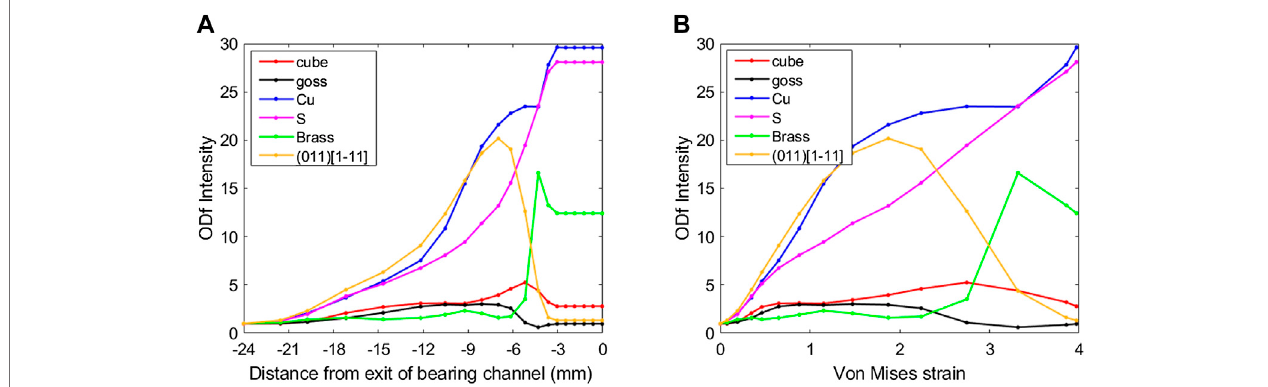
FIGURE 8 | Through-extrusion texture components development prediction by the Alamel model with parameters giving the best fi t to the measured texture at 350 ° C, plotted as a function of (A) the Von Mises strain, (B) distance from exit of bearing channel along the extrusion direction.